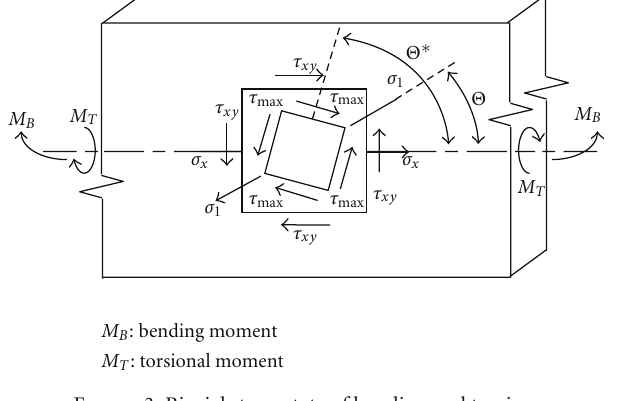
Figure 3: Biaxial stress state of bending and torsion.